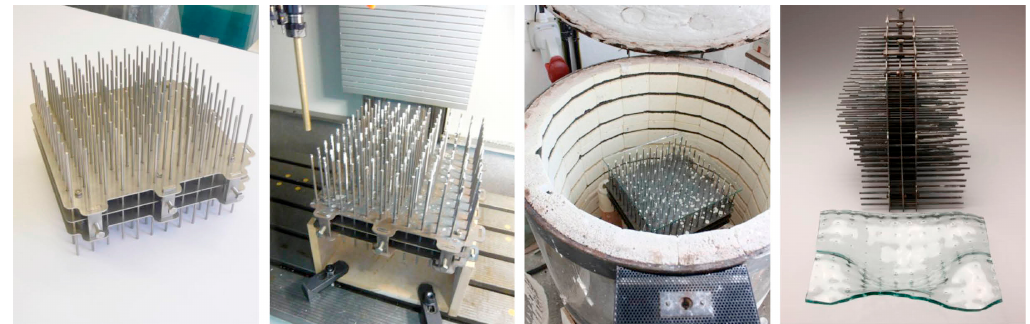
Figure 1. Initial explorations by the author of using Reconfigurable Pin Tooling (RPT) in combination with the glass-slumping technique, (photos: Jorgensen, T. 2010).